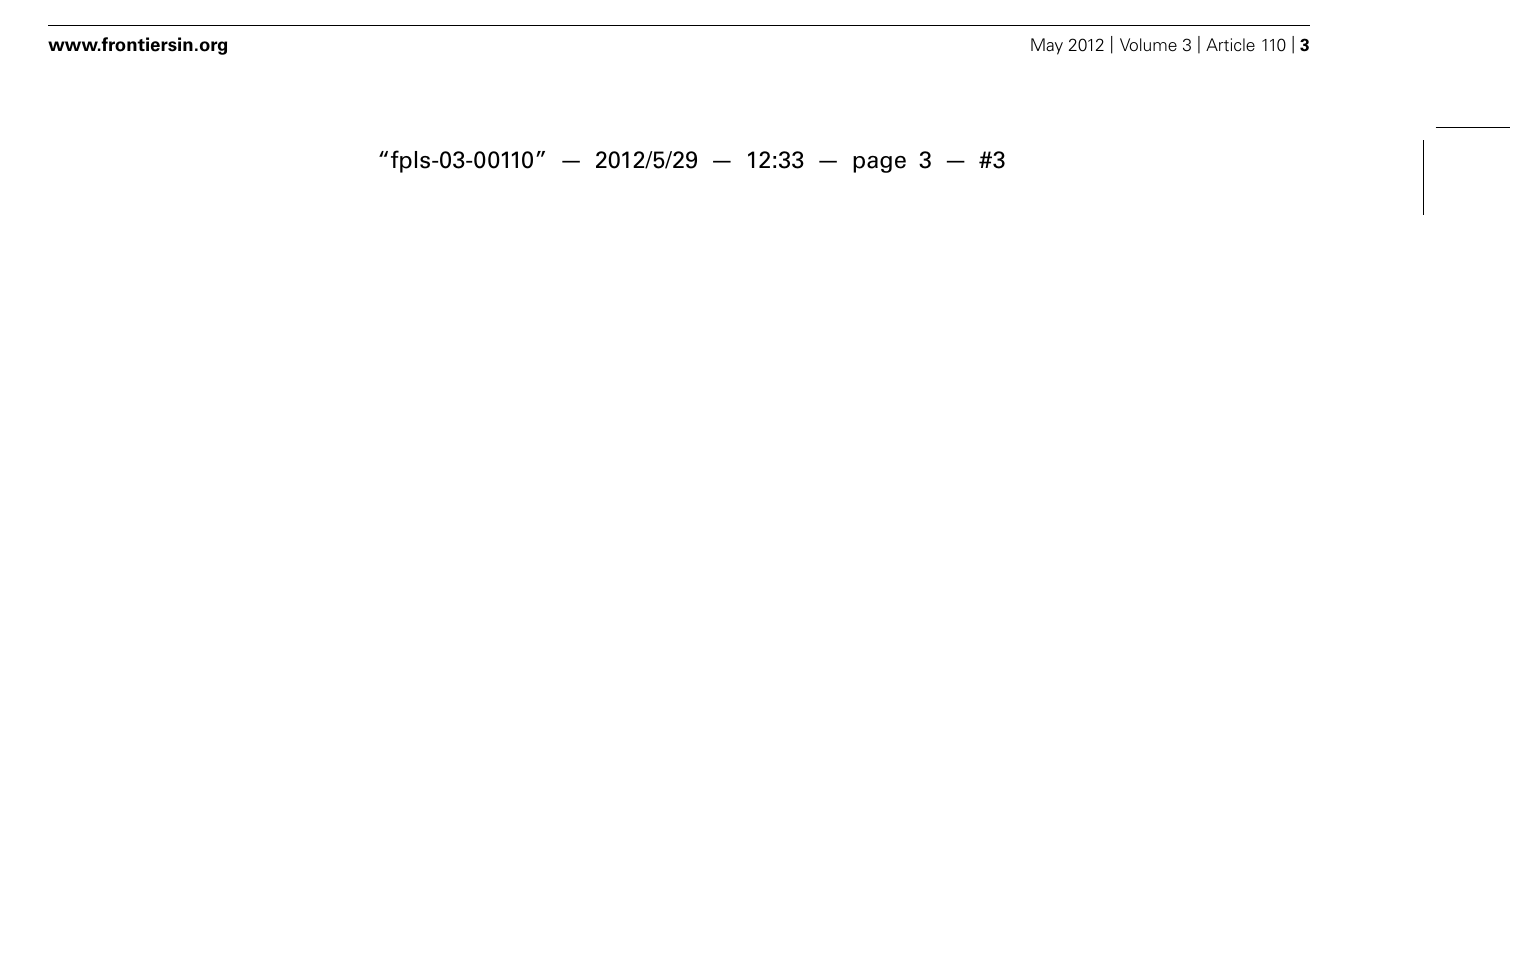
table (http://proteome.dc.affrc.go.jp/Soybean/omics/). Resource information of transcripts, proteins, and metabolites can be accessed in a unified manner. Corresponding counterparts are shown in a